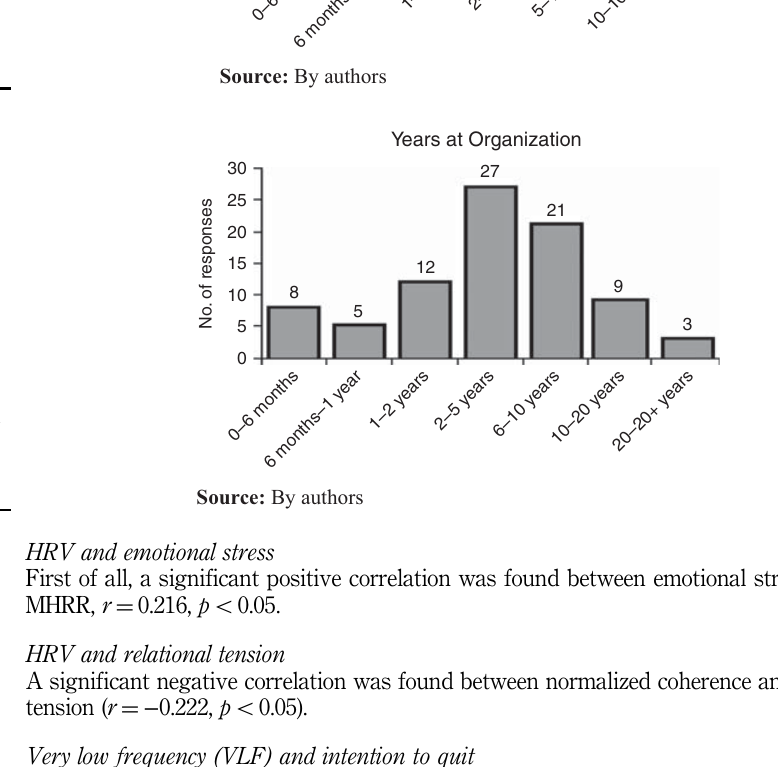
Figure 7. Years at current job of participants as reported from